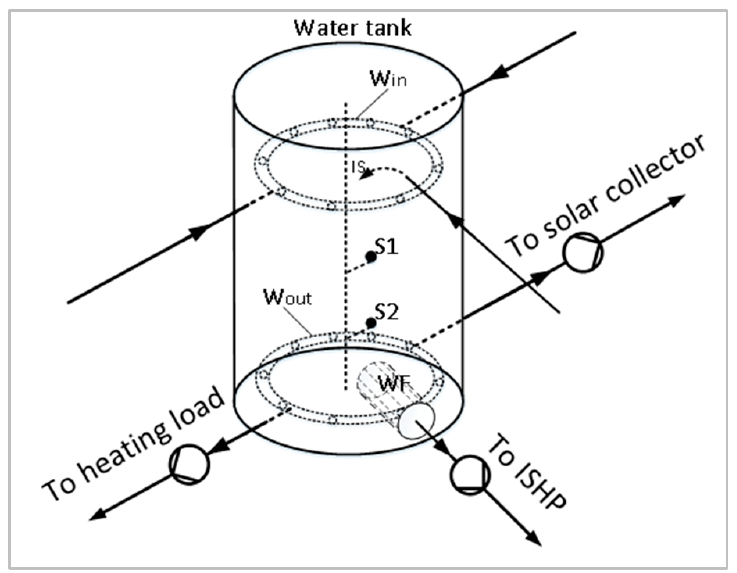
Figure 2. Design of the heat storage tank (Win: water inlet, Wout: water outlet, WF: water filter, IS: ice slurry inlet, S1 and S2: ice level sensors).